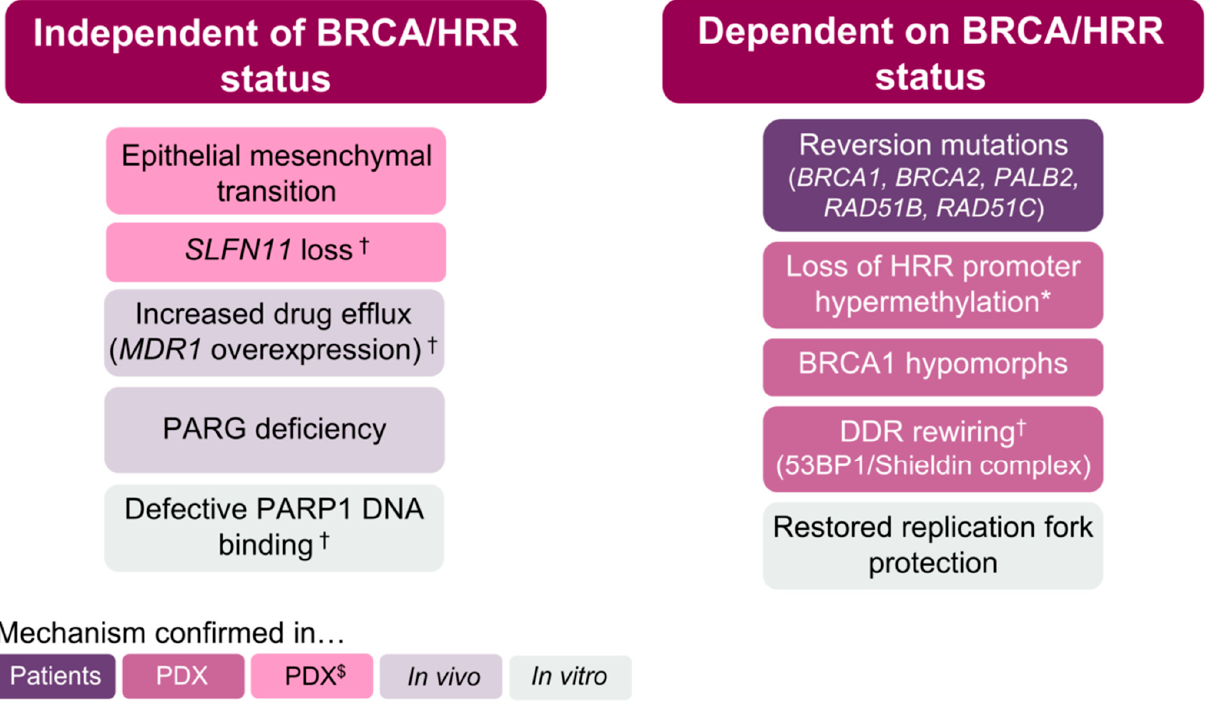
Figure 3. Mechanisms of resistance to PARPi. * also identified in patients with platinum-resistant tumours; † also reported in one patient; $ identified in models derived from tumour types where PARPi are not currently approved.